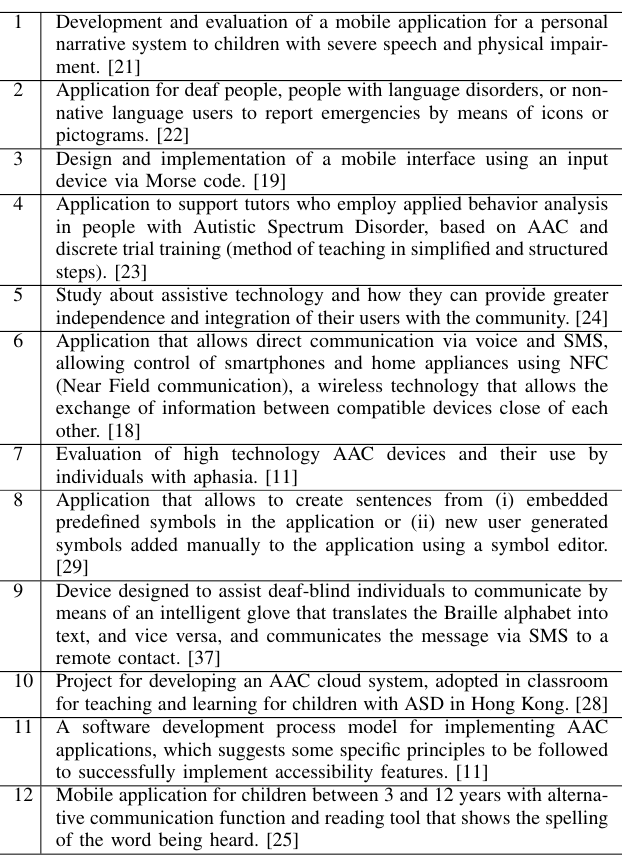
TABLE VII E XAMPLES OF PAPERS FOCUSING ON